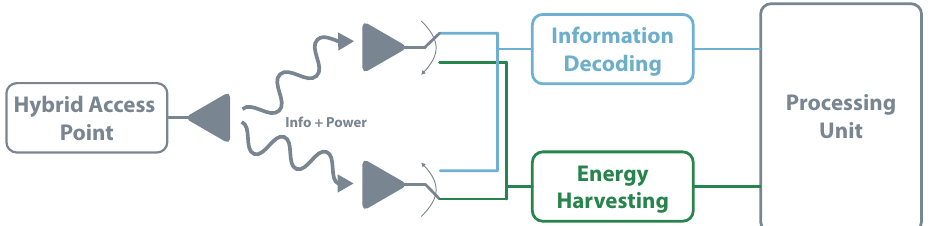
Figure 16. SWIPT—antenna switching